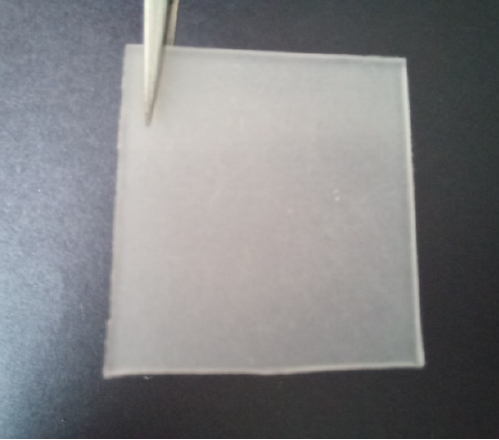
Figure 13. PEVA composite film with a stearic-acid-modified dolomite filler .